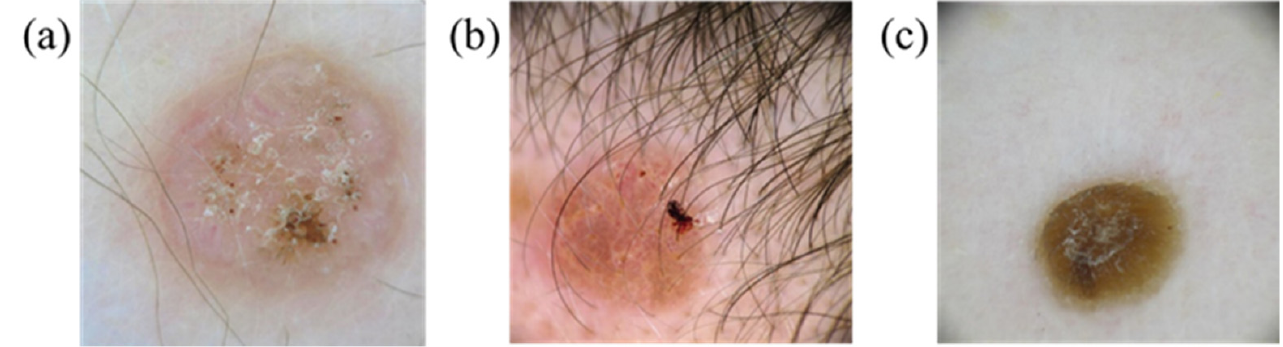
Figure 4. Seborrheic keratosis ( a , b ) due to hyperplasia of mutant epidermal keratinocytes and